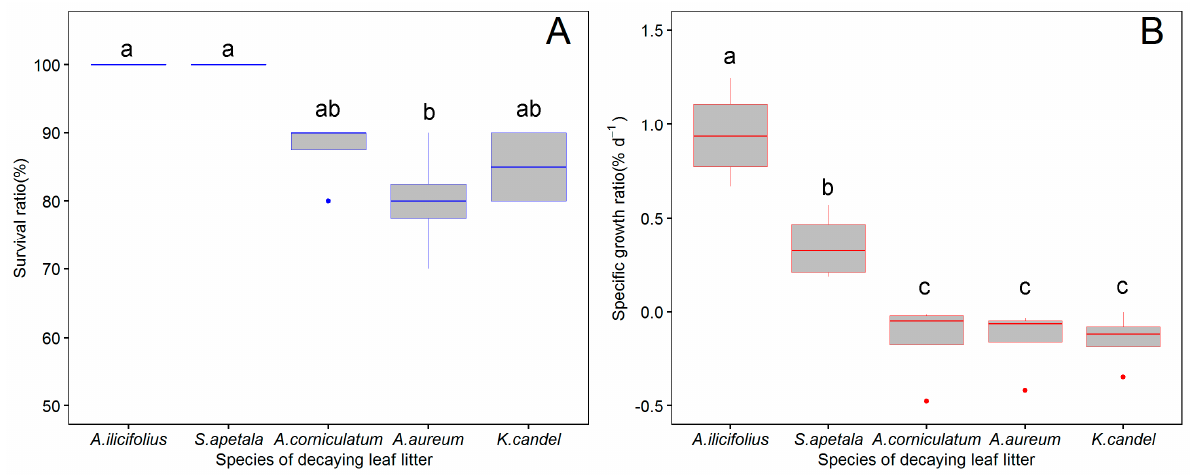
Figure 1. Boxplot of survival ratio (( A ), blue) and specific growth ratio (( B ), red) of P. canaliculata on decaying leaf litter of five species of mangroves. Species with the same letter are not significantly different (Kruskal–Wallis with Dunn–Bonferroni or Tukey tests).